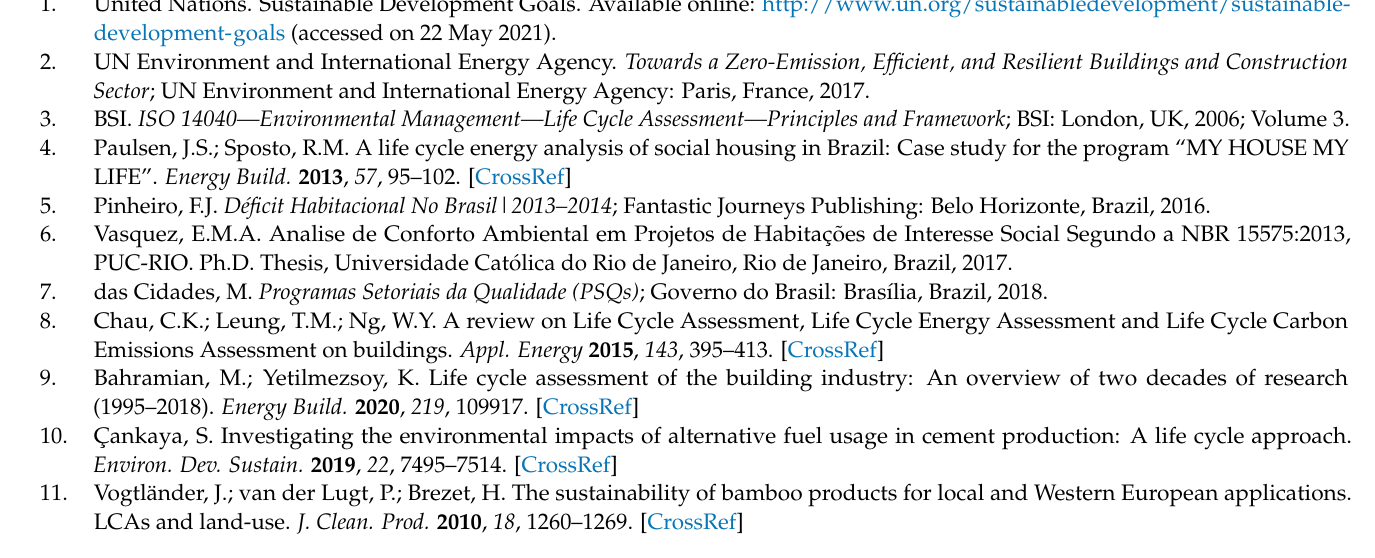
Figure S2: Climate Change impact—comparison between concrete and ceramic blocks, Figure S3: Human Health impact—comparison between concrete and ceramic blocks, Figure S4: Ecosystem Quality impact—comparison between concrete and ceramic blocks, Figure S5: Resource Depletion impact—comparison between concrete and ceramic blocks, Figure S6: Human Health impact considering the housing deficit projection, Figure S7: